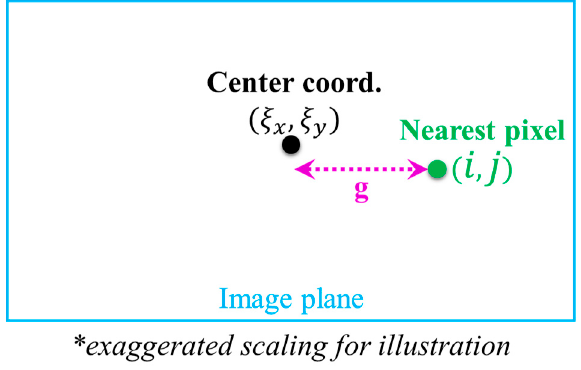
Figure 11. Image plane coordinates system.